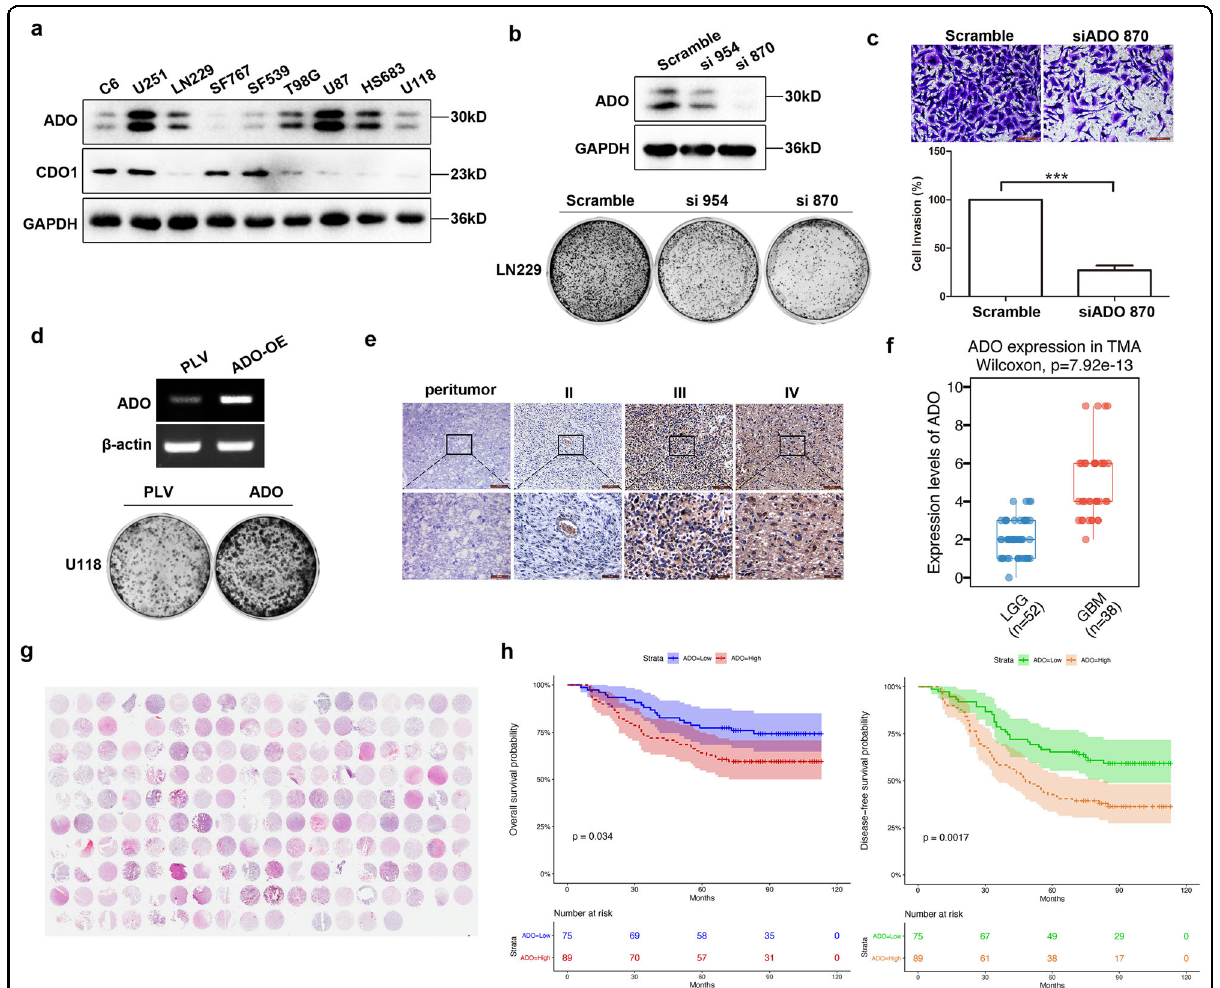
Fig. 1 ADO functions as an oncogene in glioma. a ADO and CDO1 protein levels in 9 glioma cell lines. b , c siRNA of ADO (870, 954) corresponding to a decrease in clonal growth and invasion of LN229 cells. d overexpression (OE) ADO in U118 and SF767 cells corresponding to clonal growth. e ADO expression levels in 108 glioma patient samples and 18 normal brain sections obtained from intracranial aneurysms and peritumor. Immunoreactive score (IRS) based on staining intensity and distribution was then used to evaluate ADO expression in low-grade gliomas (LGG) and GBMs ( f ). Scale bars = 100 μ m and 50 μ m. g ADO is highly expressed in GBM in a cohort consisting of 180 glioma tissues, localized to the cytoplasm, and negatively correlated with the overall survival rate and disease-free survival of glioma patients ( h ). All results are representative of three independent